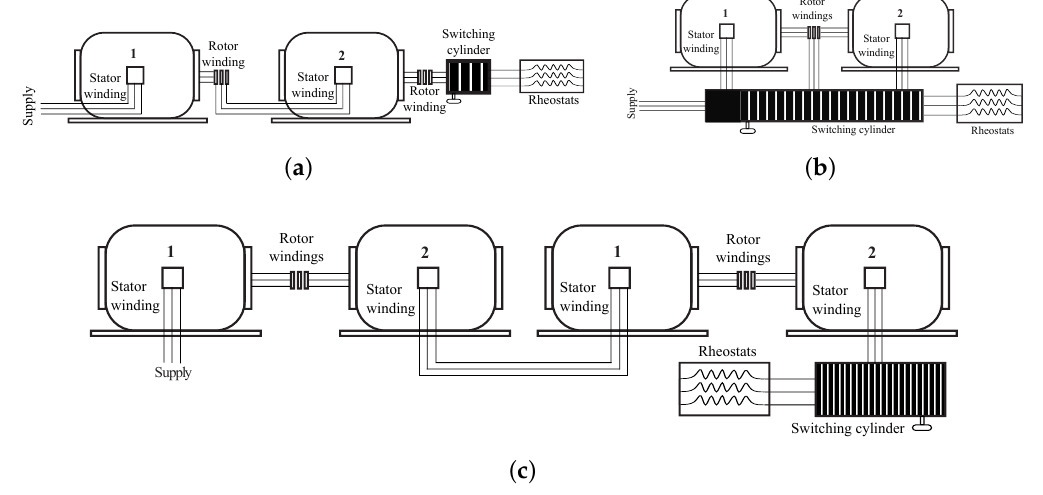
Figure 1. Steinmetz cascade system examples: ( a ) two motors with rotor of primary motor connected to secondary stator, ( b ) two motors with both rotors connected to each other, and ( c ) four motors